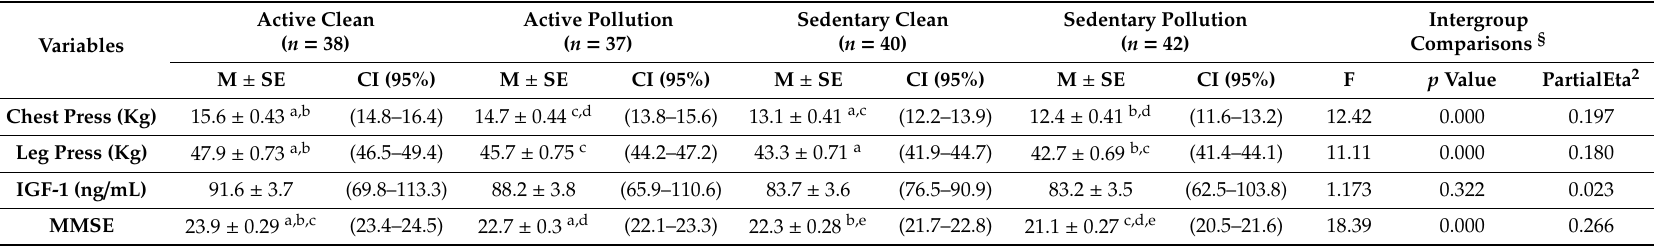
Table 4. Intergroup comparisons: POST-test